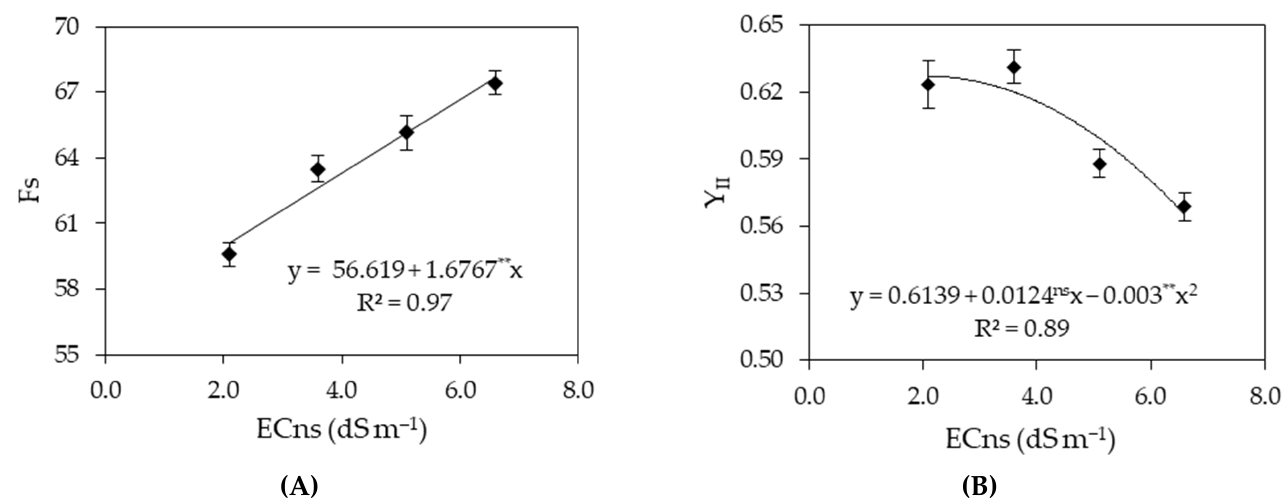
Figure 8. Initial fluorescence before the saturation pulse—Fs ( A ) and the quantum efficiency of photosystem II in the light phase—Y II ( B ) of Japanese cucumber as a function of the levels of electrical conductivity of the nutrient solution (ECns), grown in a hydroponic system, 40 days after transplanting. ns and **, respectively, not significant and significant at a p ≤ 0.01. Vertical lines represent the standard error of the mean ( n = 4). Table 5. Summary of the analysis of variance (ANOVA) for the number of fruits (NF), average fruit weight (AFW), total production per plant (TPP), average fruit length (AFL), and average fruit diameter (AFD) of Japanese cucumber grown in a hydroponic system with saline nutrient solution and foliar application of salicylic acid, 45 days after